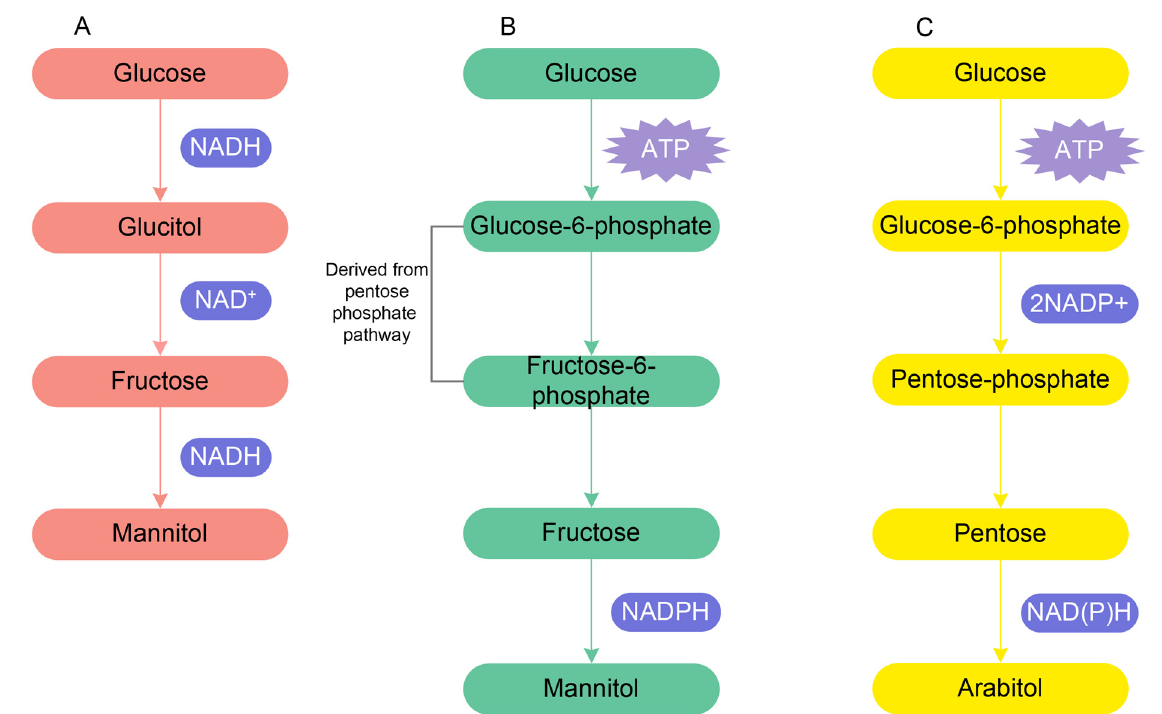
Figure 2. ( A ). Mannitol synthesis from glucose. ( B ). Mannitol synthesis from the hexose phosphate derived from the pentose phosphate pathway. ( C ). Arabitol synthesis from pentose sugar via the pentose phosphate pathway.